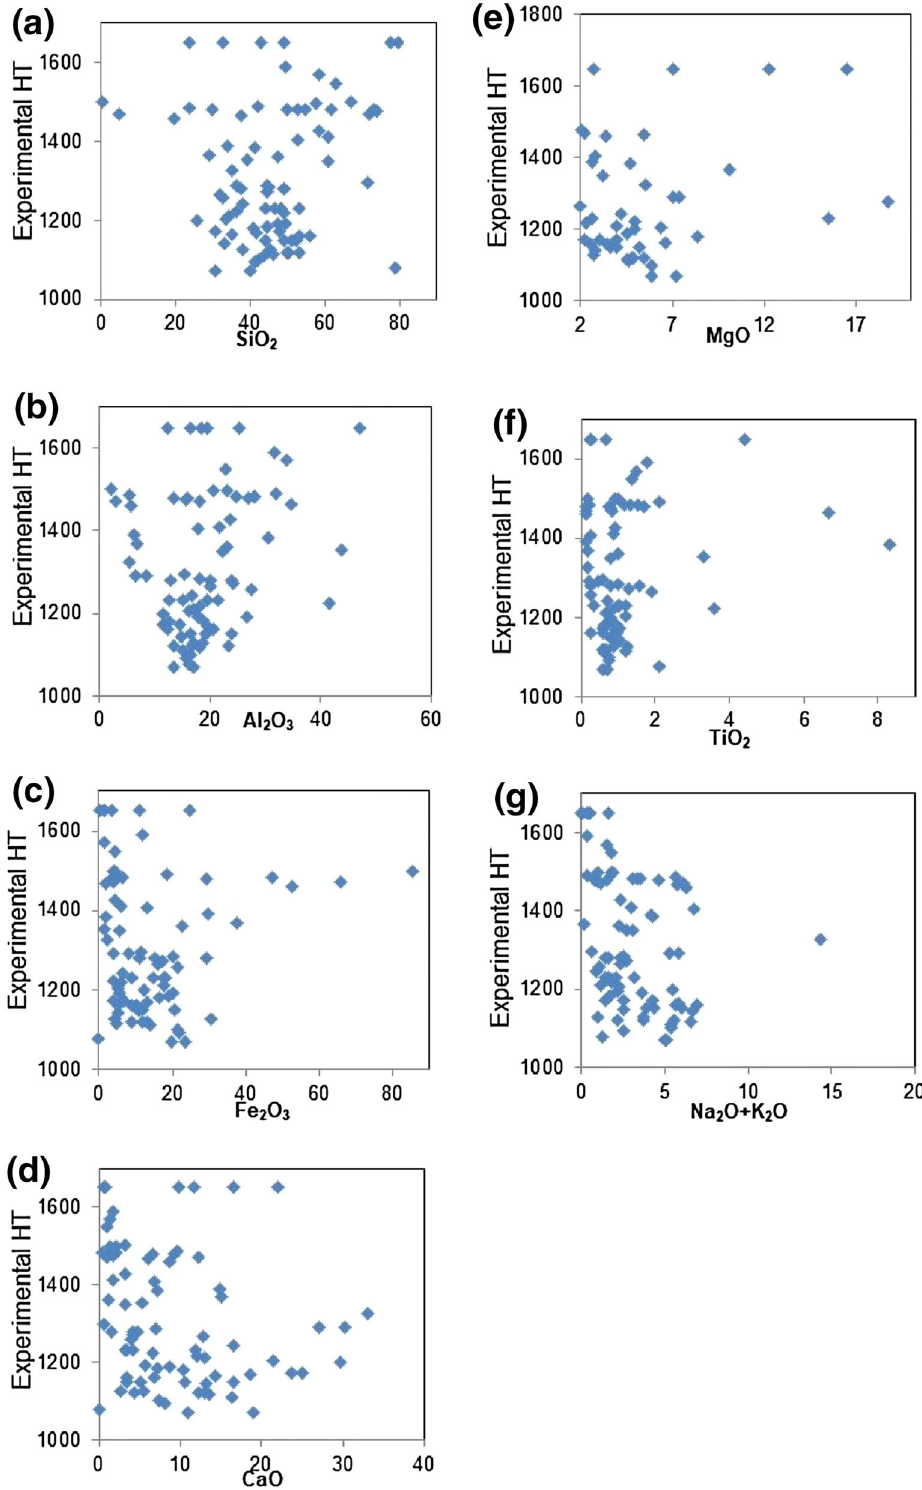
Fig. 2 Cross-plots of weight percentages (wt%) of individual metal oxides versus ST